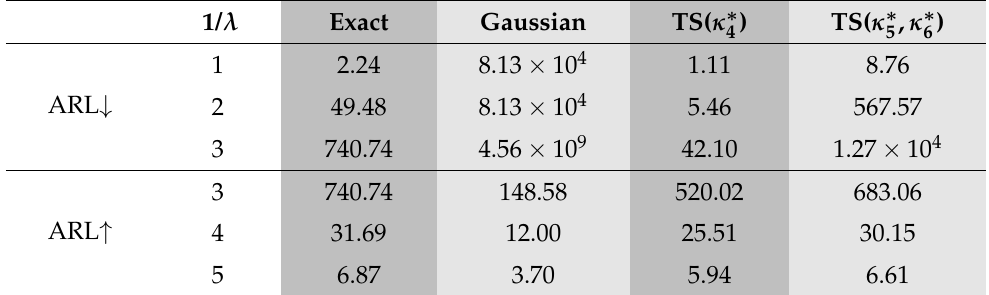
Table 2. In- and out-of-control ARLs for a Gamma ( γ = 2, 1 of size n = 5.